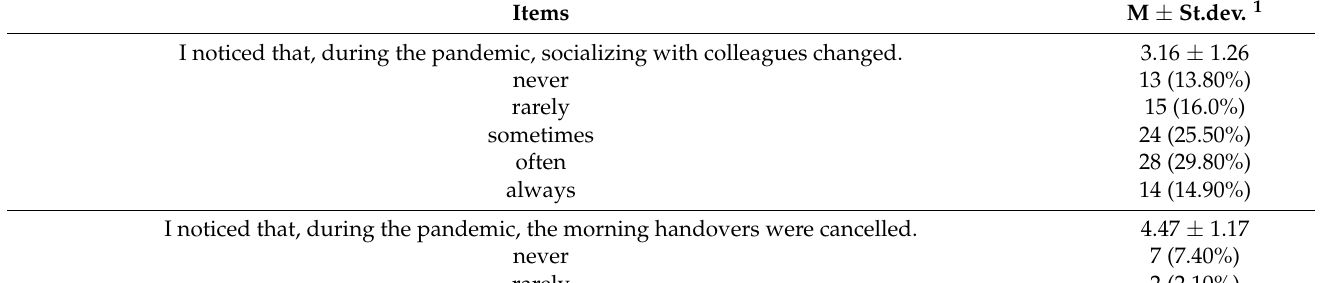
Table 7. Relationship with superiors and colleagues—in the last 6 months.